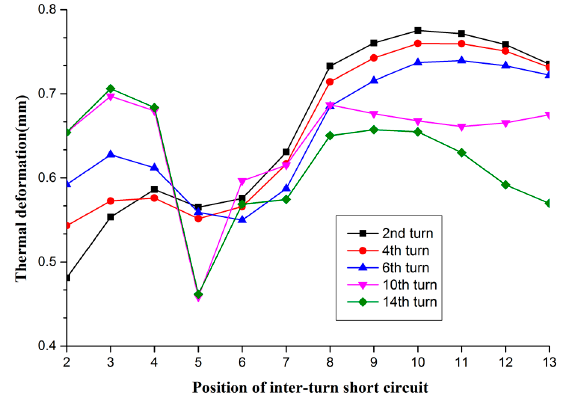
Figure 12. Thermal deformation of front-end coil of the magnetic pole.